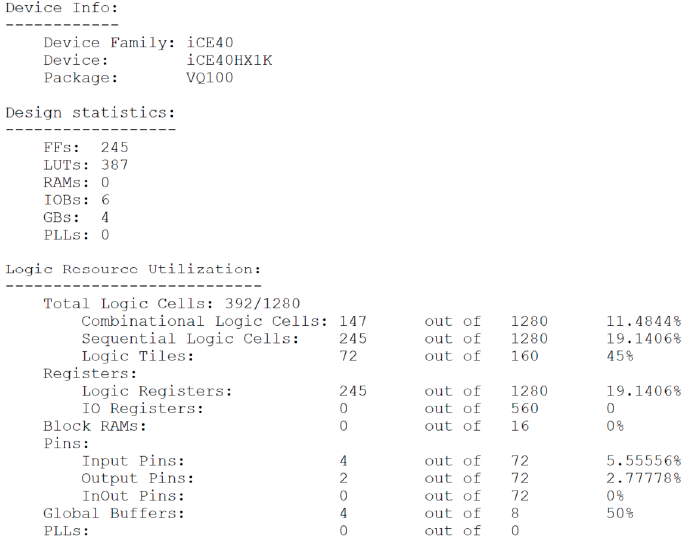
Figure 19. Synthesis Report—Logic Resource Utilization.